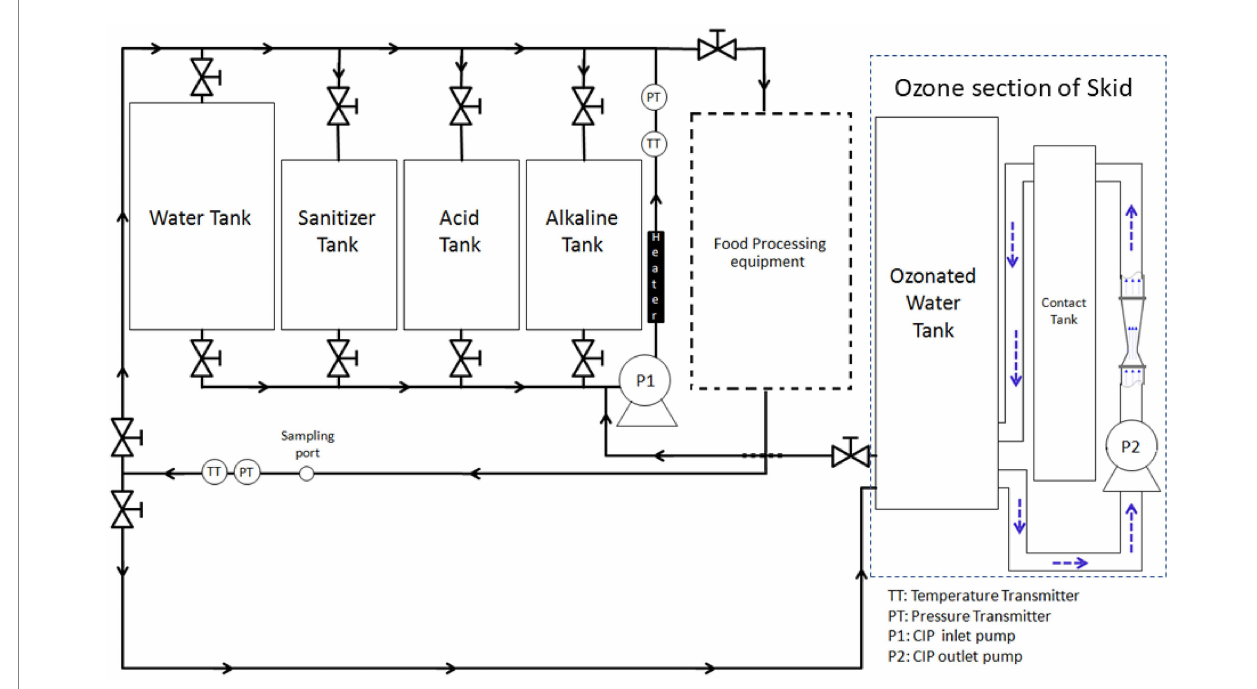
FIGURE 1 Representation of pilot-scale cleaning-in-place system integrated with ozone generator and coupled with a pilot-scale food processing equipment.